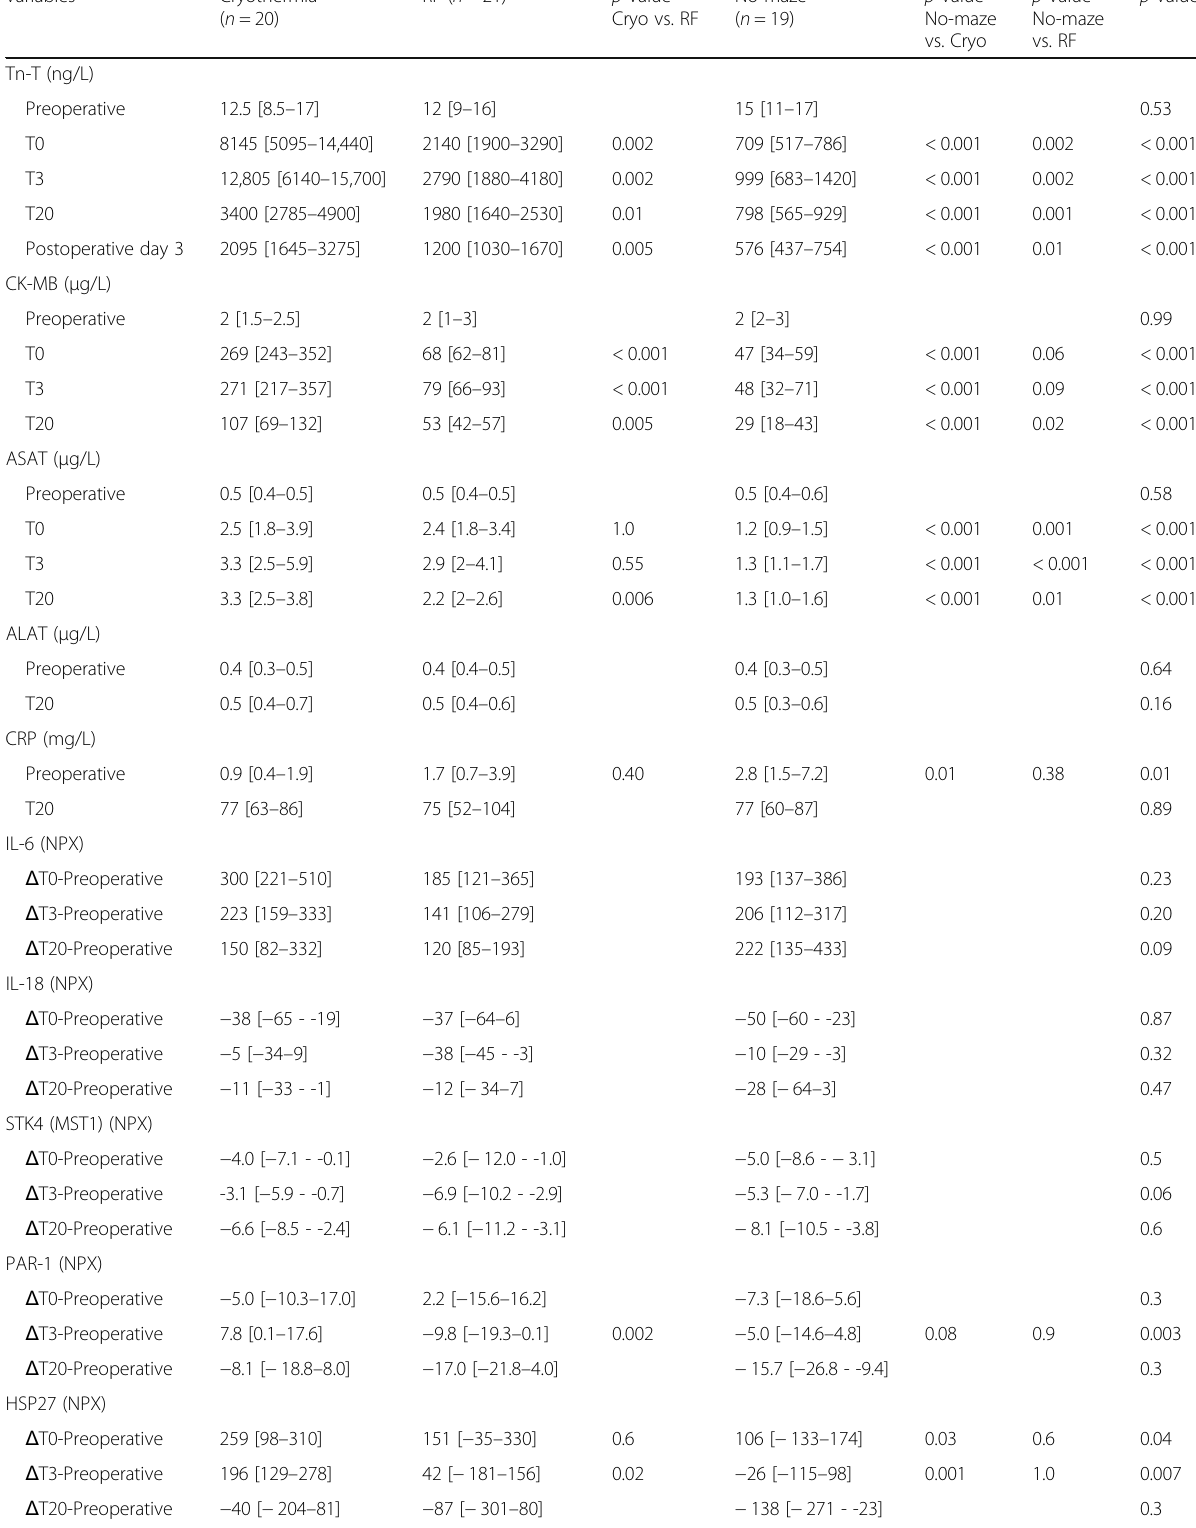
Table 3 Biochemical